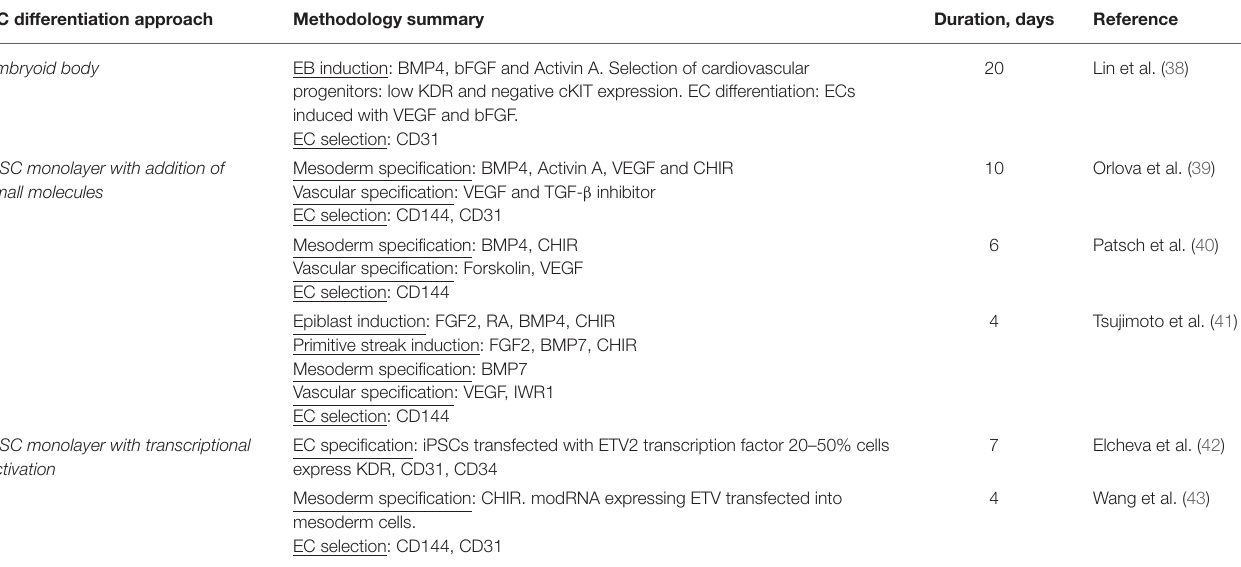
TABLE 1 | Summary of highlighted EC differentiation protocols. EC differentiation approach